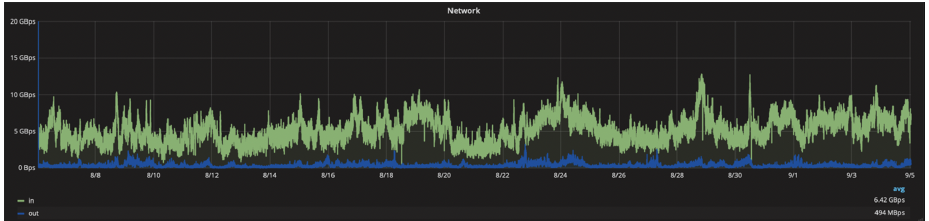
Figure 2. Plot showing the total network throughput of the Dell19 generation of Worker